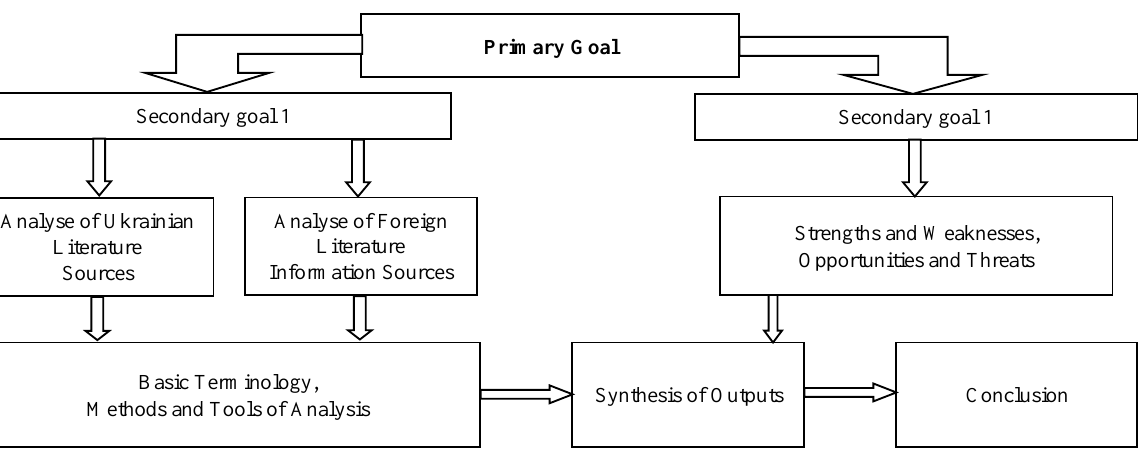
Figure 1. Flowchart of the research